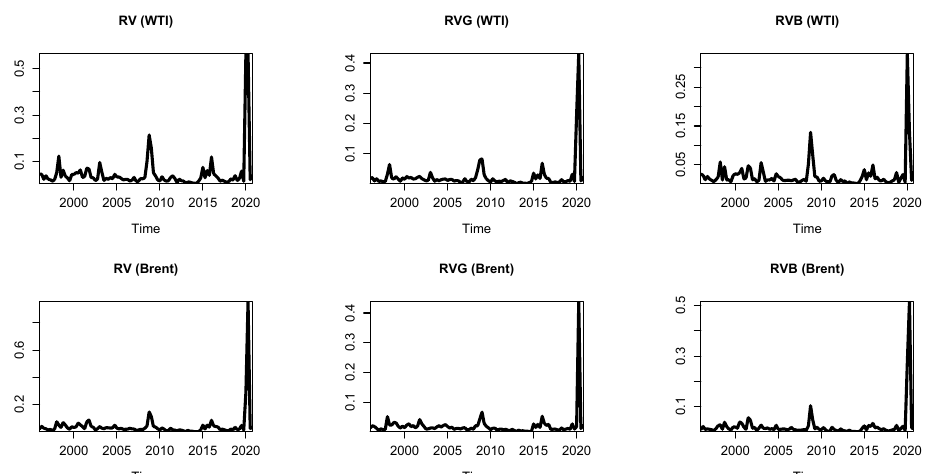
Figure 1. Realized volatility. For better readability, the vertical axes of the panels are not the same for all time series. From frequency counts of “uncertainty” (and its variants) in the quarterly Economist Intelligence Unit (EIU) country reports from 1996 for 8 of the 143 countries, Ahir et al. [28] constructed quarterly indices of economic uncertainty for 37 countries in Africa, 22 in Asia and the Pacific, 35 in Europe, 27 in the Middle East and Central Asia, and 22 in